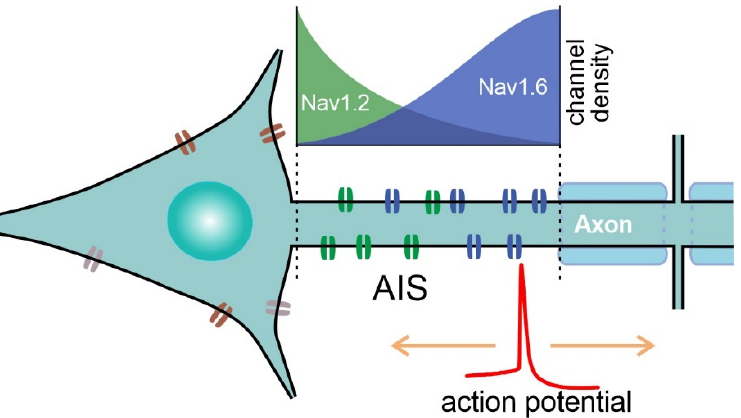
Figure 4. Schematic of sodium channel distribution at the AIS of pyramidal neurons. NaV1.6 density is higher at the distal part of the AIS, whereas NaV1.2 channels are clustered at the proximal part of the AIS. APs are initiated at the distal part of the AIS, which is enriched with low-threshold NaV1.6